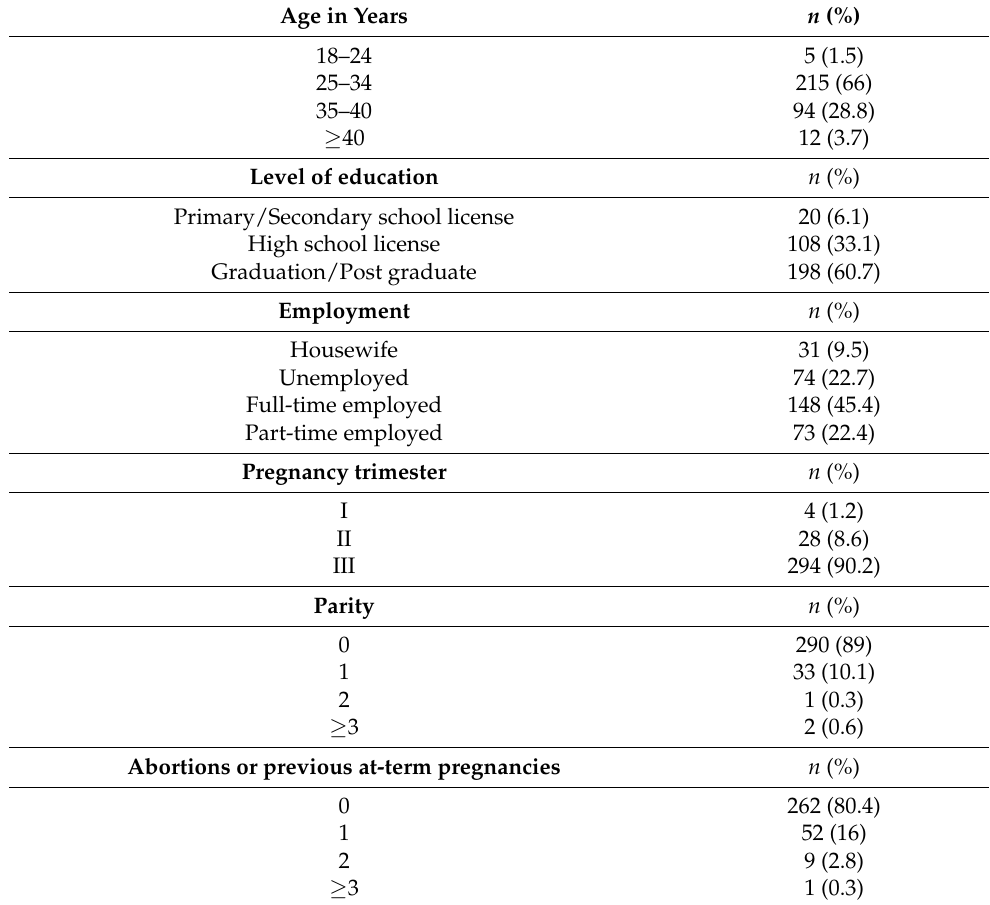
Table 1. Socio-demographic characteristics and data related to pregnancy of the 326 pregnant women recruited in the